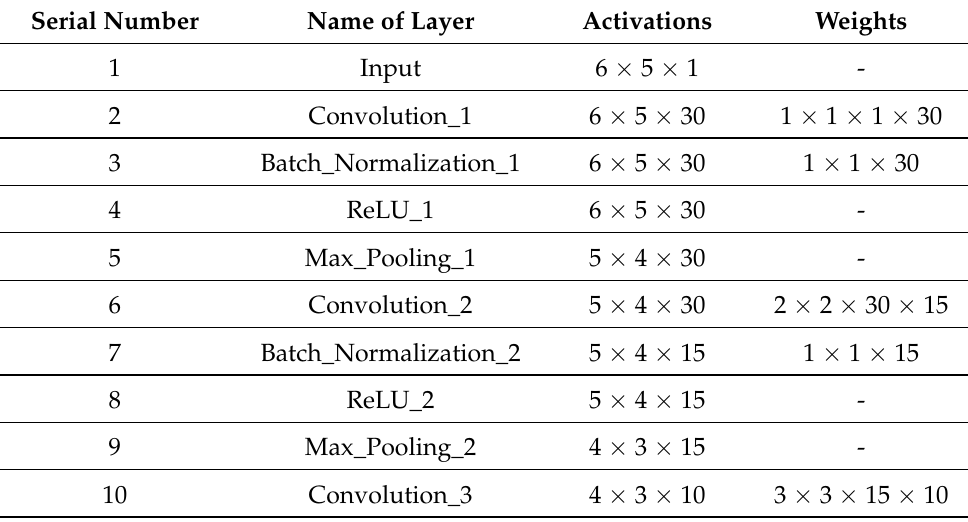
Table 2. The proposed CNN architecture and its